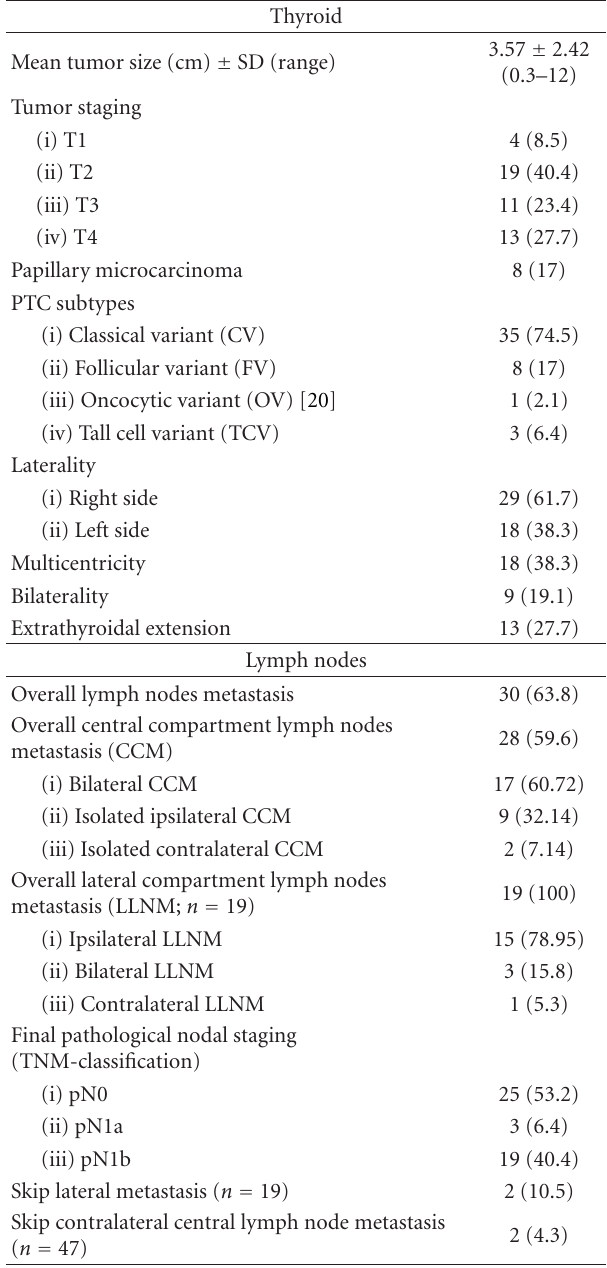
Table 2: Histopathological features; n = 47 (% age).